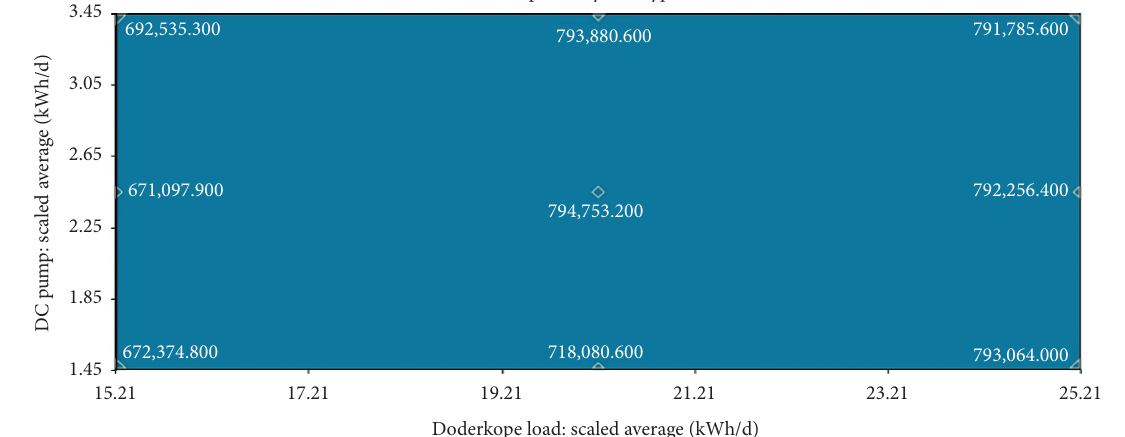
Figure 12: Sensitivity NPC output for HRES 1. Optimal system type